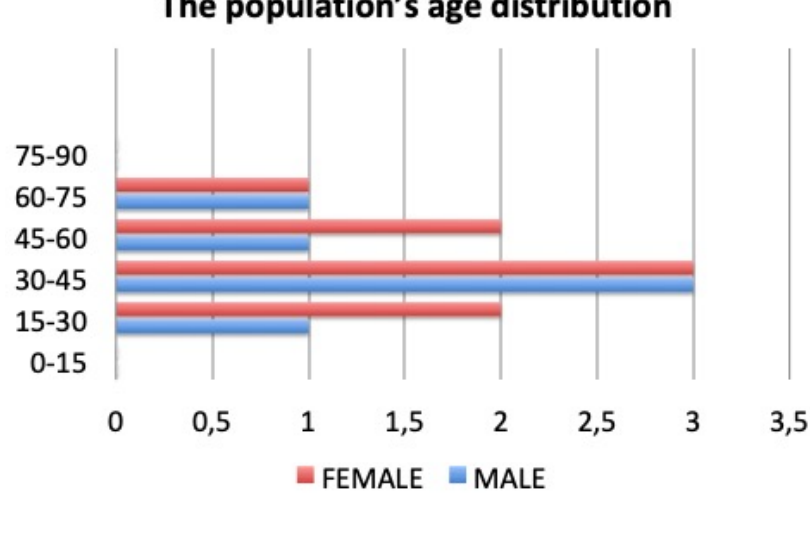
Table 1. The population’s age distribution . Relationship between age (axis y) and number of patients treated (axis